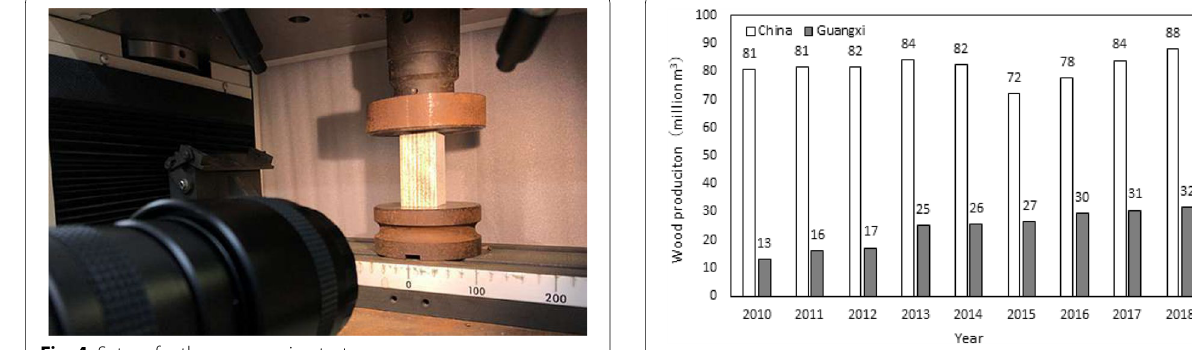
Fig. 6 Wood production in the plantation forests of China and Guangxi